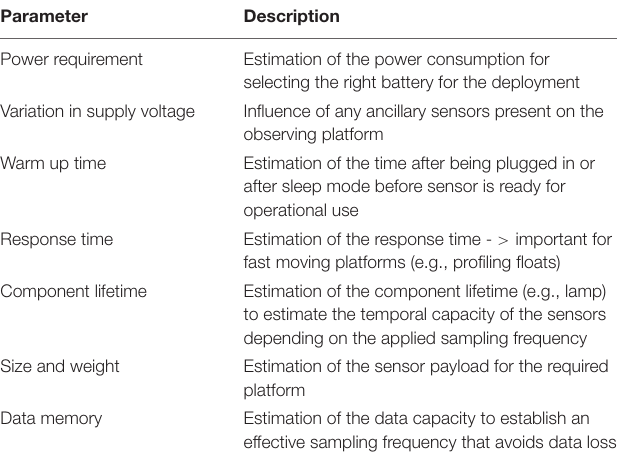
TABLE 4 | Examples of parameters to control before a sensor